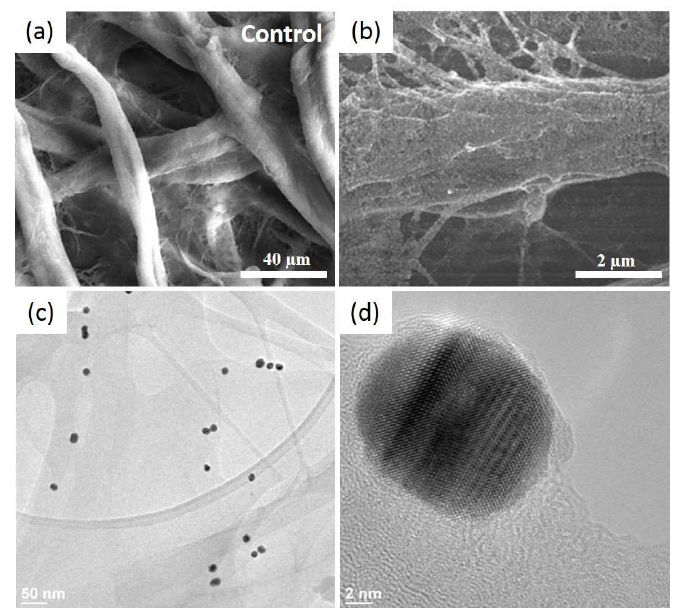
Figure 2. Representative SEM (scanning electron microscope) images of the pristine Whatman paper presenting its interconnected microfibers ( a ) and after the uniform decoration of the paper surface with the AuNSs (bright spots) ( b ), as well as typical HRTEM (high-resolution transmission electron microscope) images at low ( c ) and high resolution ( d ).